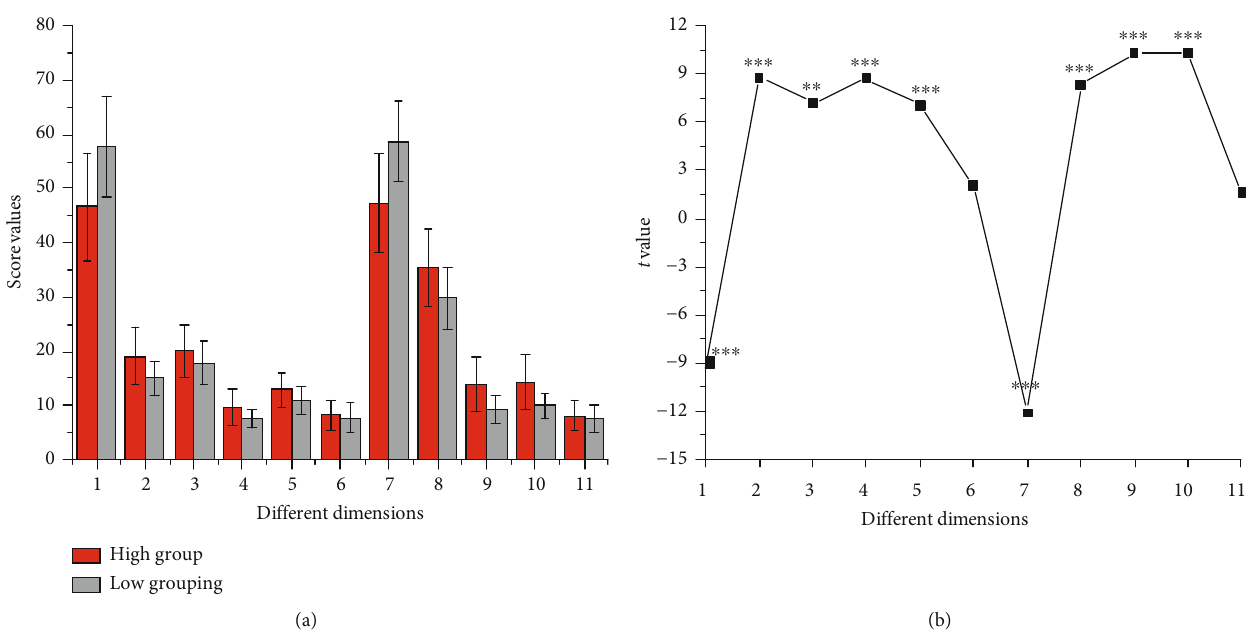
Figure 13: Comparison between the high-anxiety group and the low-anxiety group: (a) scores of di ff erent dimensions; 1: father ’ s emotional warmth; 2: father ’ s partiality; 3: father ’ s severe punishment; 4: father ’ s excessive interference; 5: father ’ s rejection; 6: father ’ s overprotection; 7: mother ’ s emotional warmth; 8: mother ’ s excessive interference; 9: mother ’ s rejection; 10: mother ’ s severe punishment; 11: mother ’ s partiality; ∗ P < 0 : 05 ; ∗∗ P < 0 : 01 ; ∗∗∗ P < 0 : 001